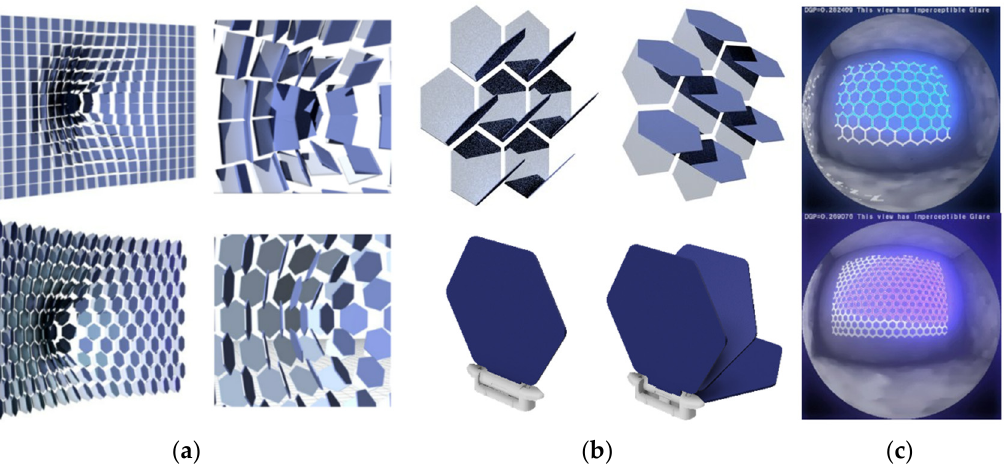
Figure 2. All computer-aided images were made using Rhinoceros Grasshopper software. ( a ) Visual representation of potential collisions during deformations using squares vs. hexagons as base elements. ( b ) Exploration of different positions of flaps. The interchangeability was kept possible for the prototype using a 3D-printed notch-system as a flap holder, insertable into an aluminum frame as shown in the bottom images. ( c ) Qualitative determination elements with a fish-eye view from behind glazing. HD file generated using the Ladybug component.